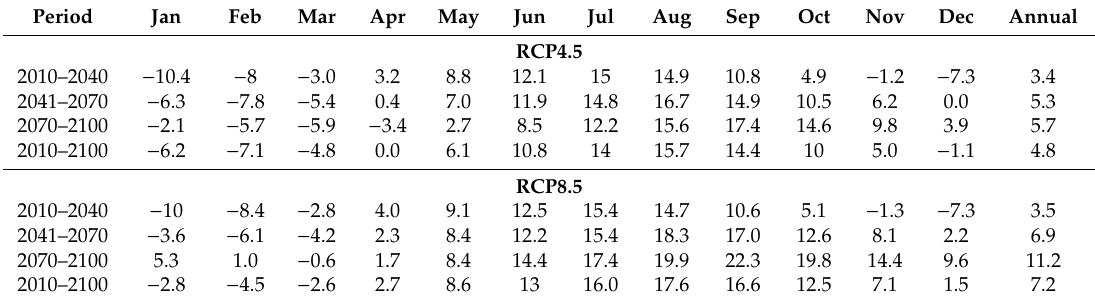
Table 5. Monthly average temperature variation ( ◦ C) under near (2010–2040), middle (2041–2070), and future (2070–2100) climate change scenarios.